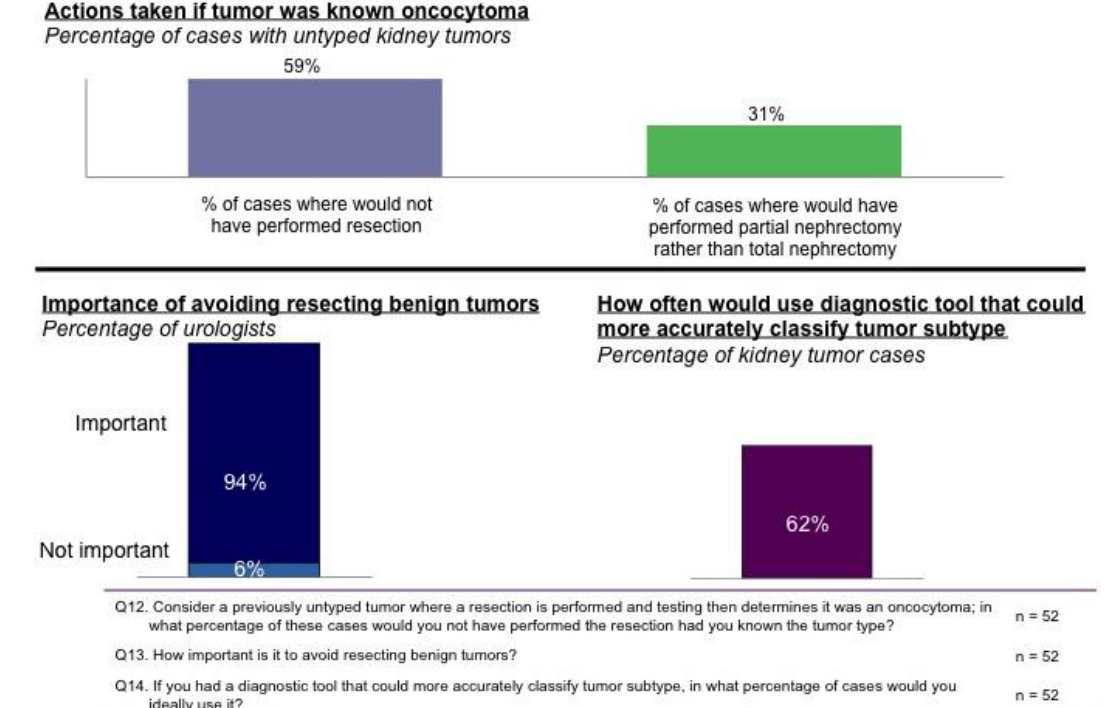
Figure 8. Modifications to practice with increased